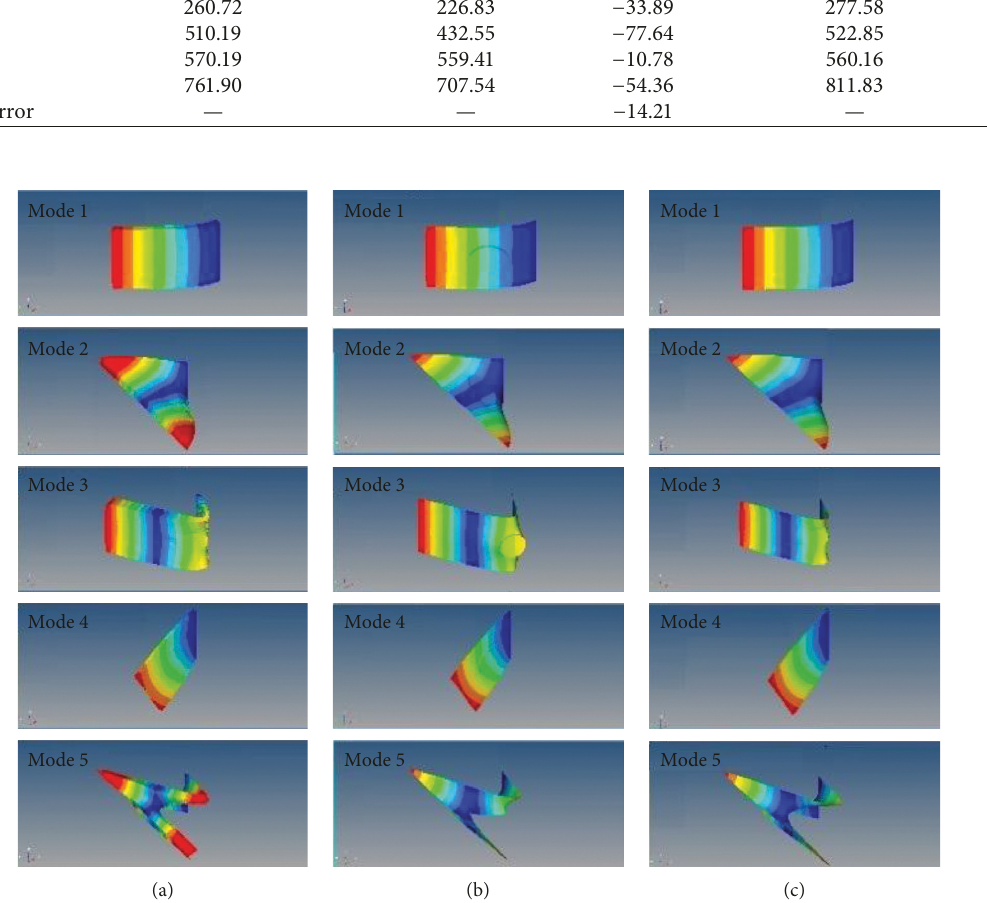
Figure 9: Various mode shapes. (a) Whole entity modeling, (b) equivalent plate, and (c) multilayered